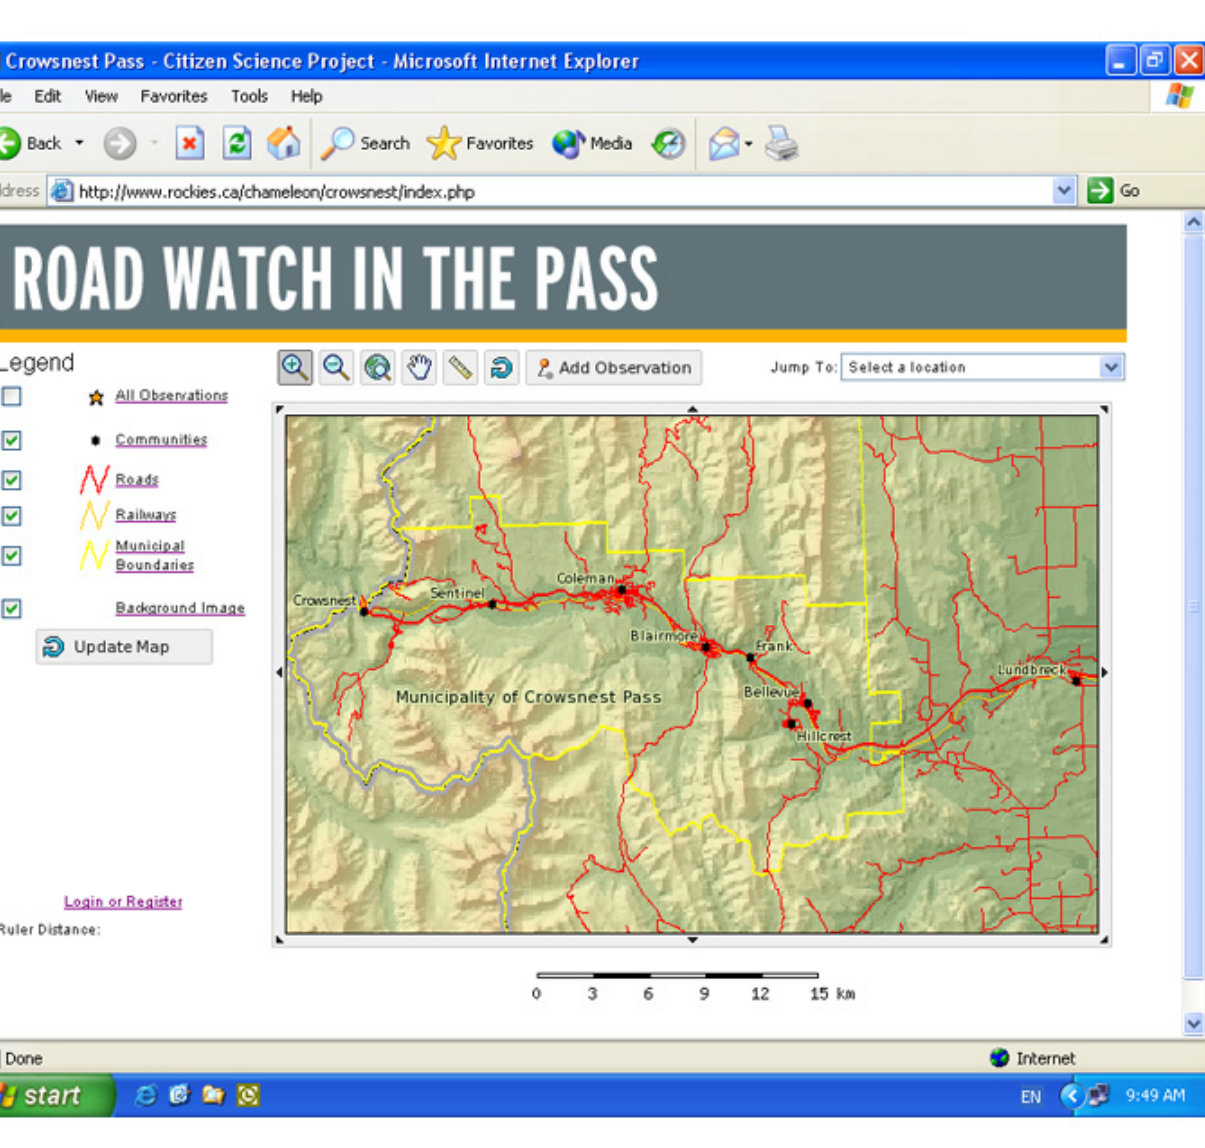
Fig. 2. Road Watch online GIS